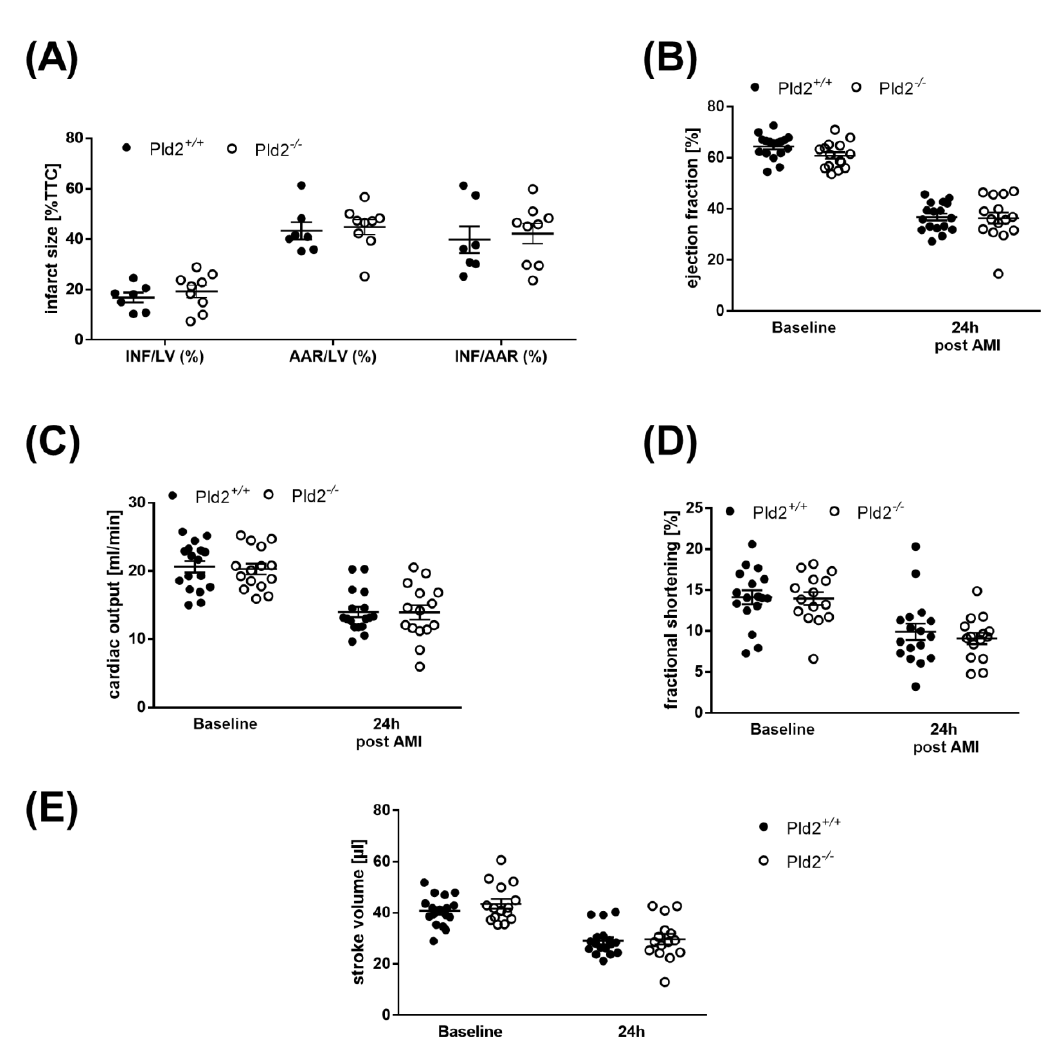
Figure 4. Unaltered infarct size and cardiac function in PLD2-deficient mice 24 h after I/R. ( A ) Determination of infarct size and area at risk (AAR) as percentage of the left ventricle (LV), and infarct size (INF) as percentage of the area at risk showed no differences as analyzed by TTC staining 24 h after I/R in Pld2 +/+ vs. Pld2 -/ - mice, n = 7–9. ( B–E ) Echocardiographic analysis (baseline versus 24 h after I/R) of ( B ) ejection fraction, ( C ) cardiac output, ( D ) fractional shortening and ( E ) stroke volume, n =